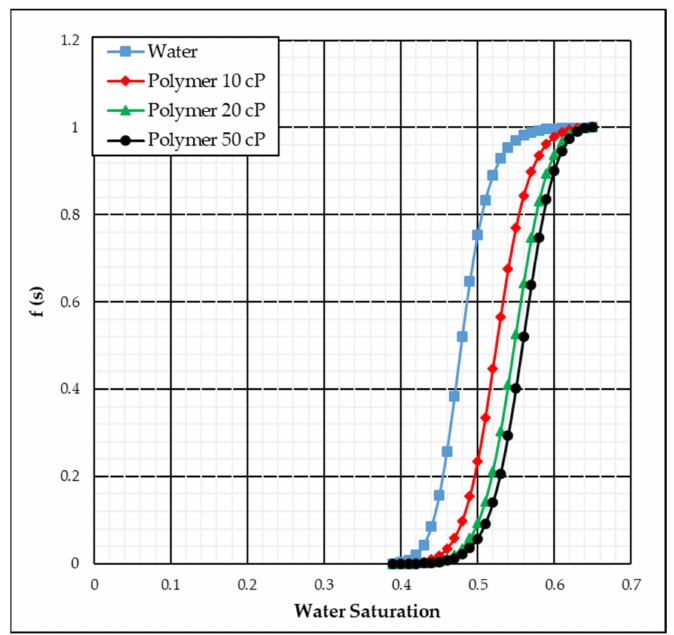
Figure 6. Buckley–Leverett functions for displacement with various fluids.